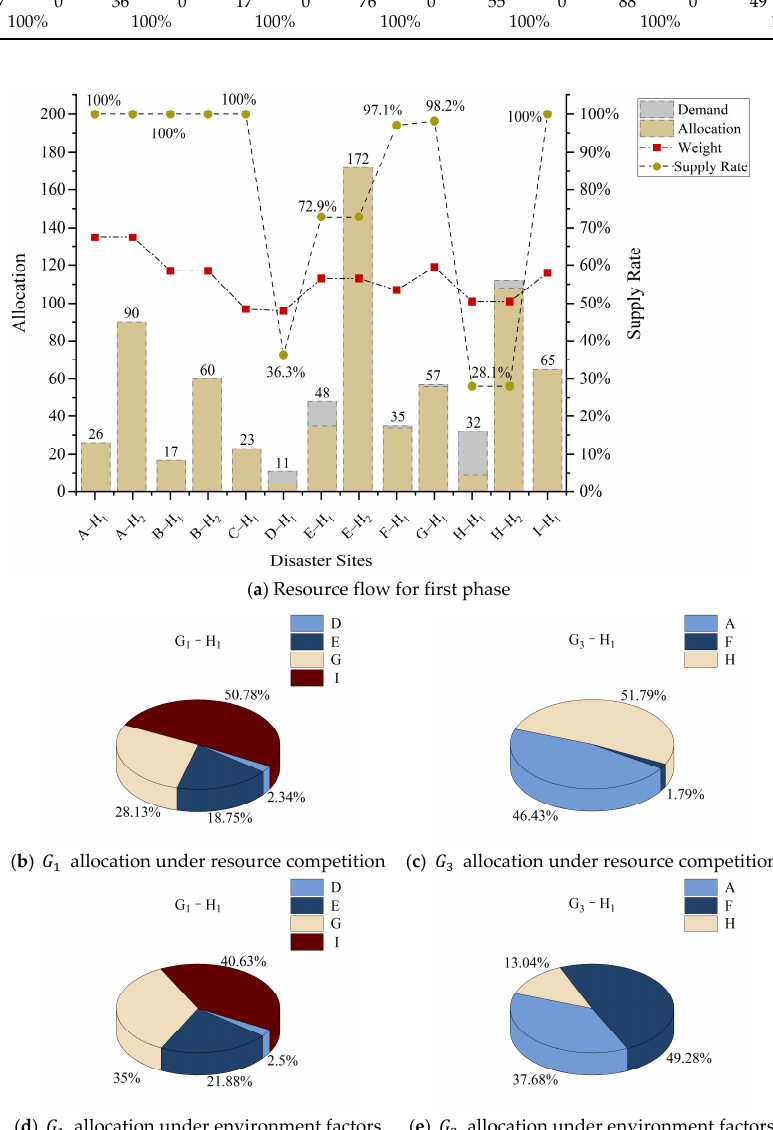
Figure 12. Allocation proportion under the influence of environmental factors.